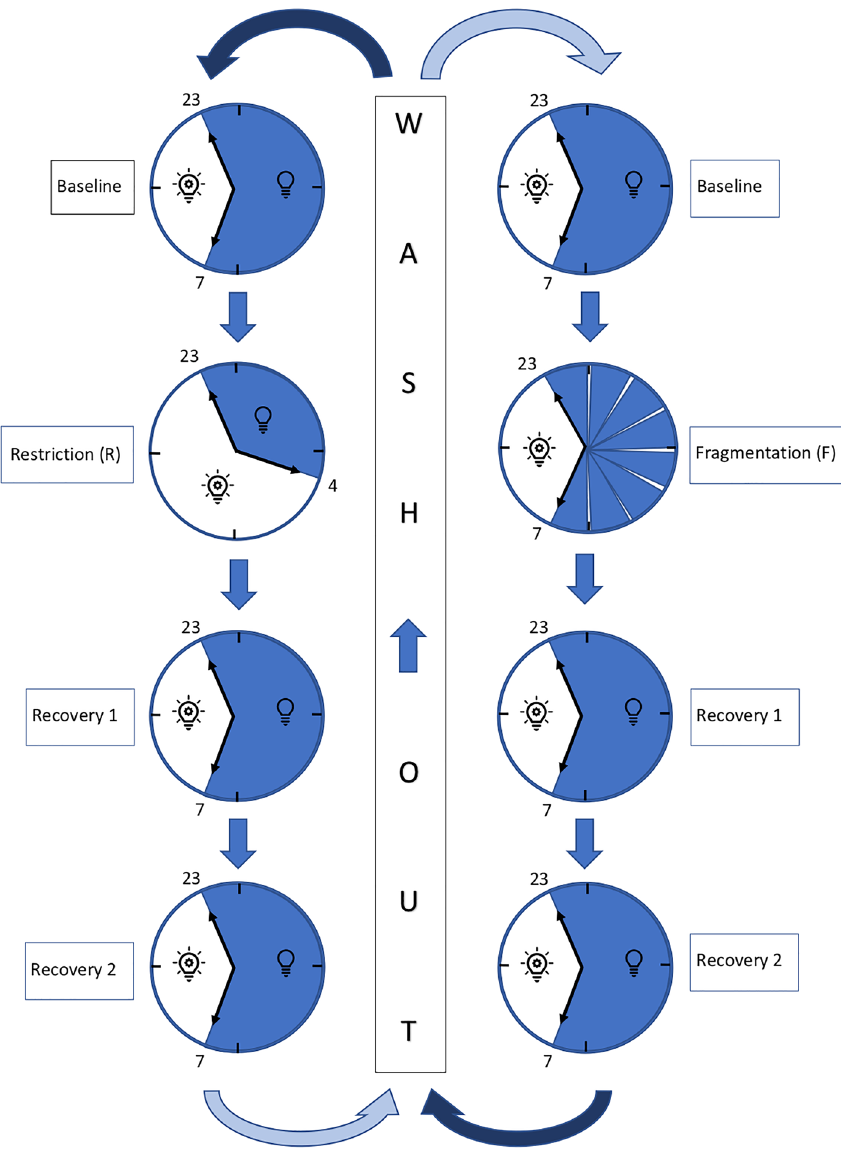
Figure 1. Study design with the interventions restriction (left side) and fragmentation (right side). A randomized cross-over-design was chosen with one group starting on the left side and one group starting on the right side. Light-on and light-off times are